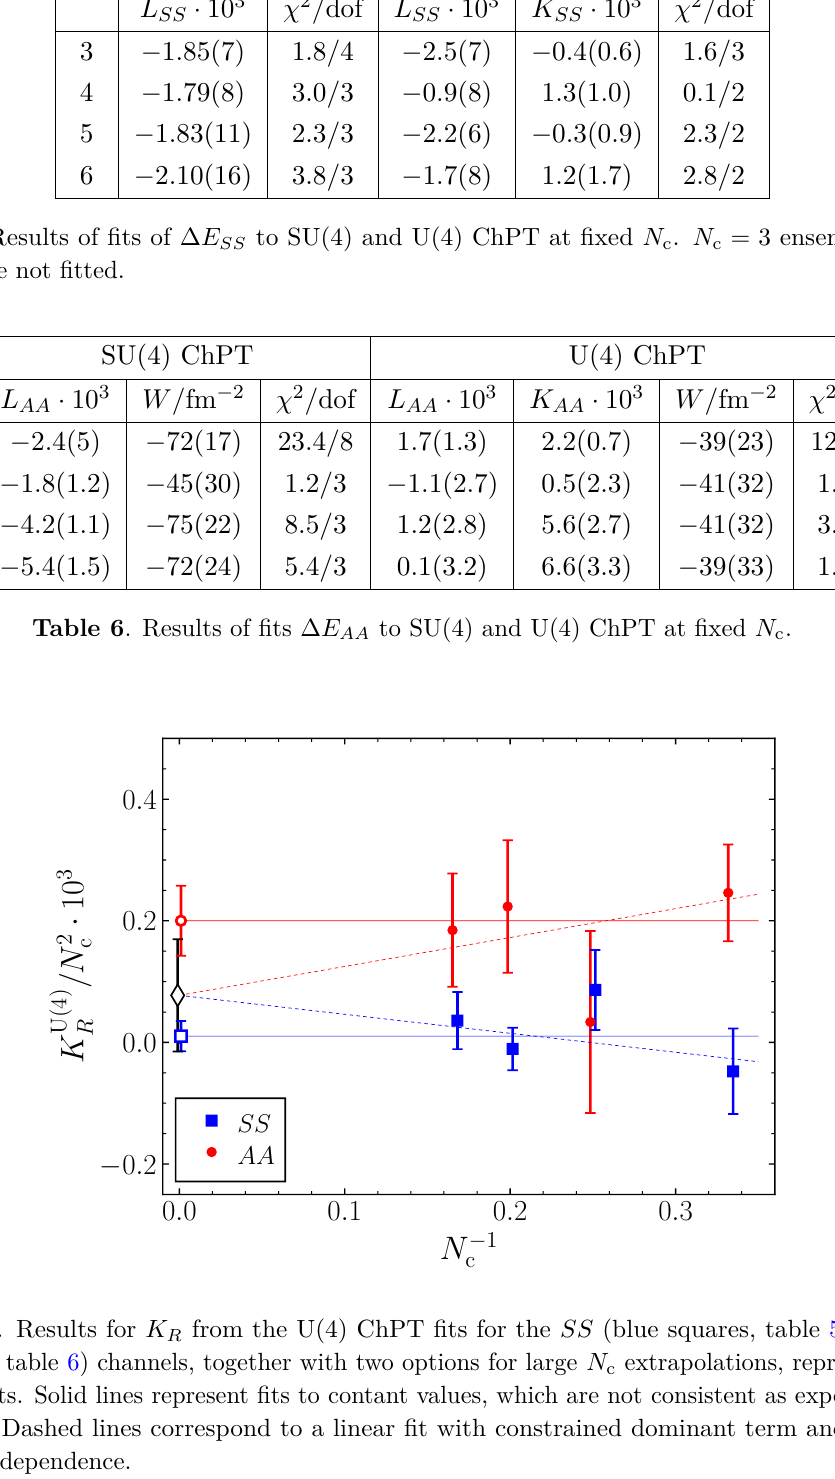
extrapolations, represented by c